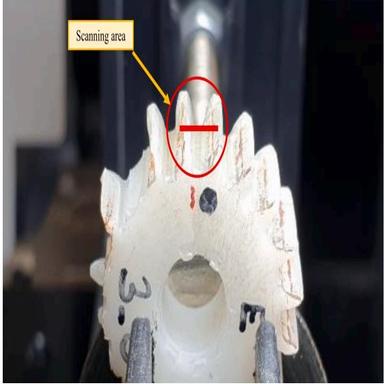
Wear measurement location in the mid plane off the tooth width.